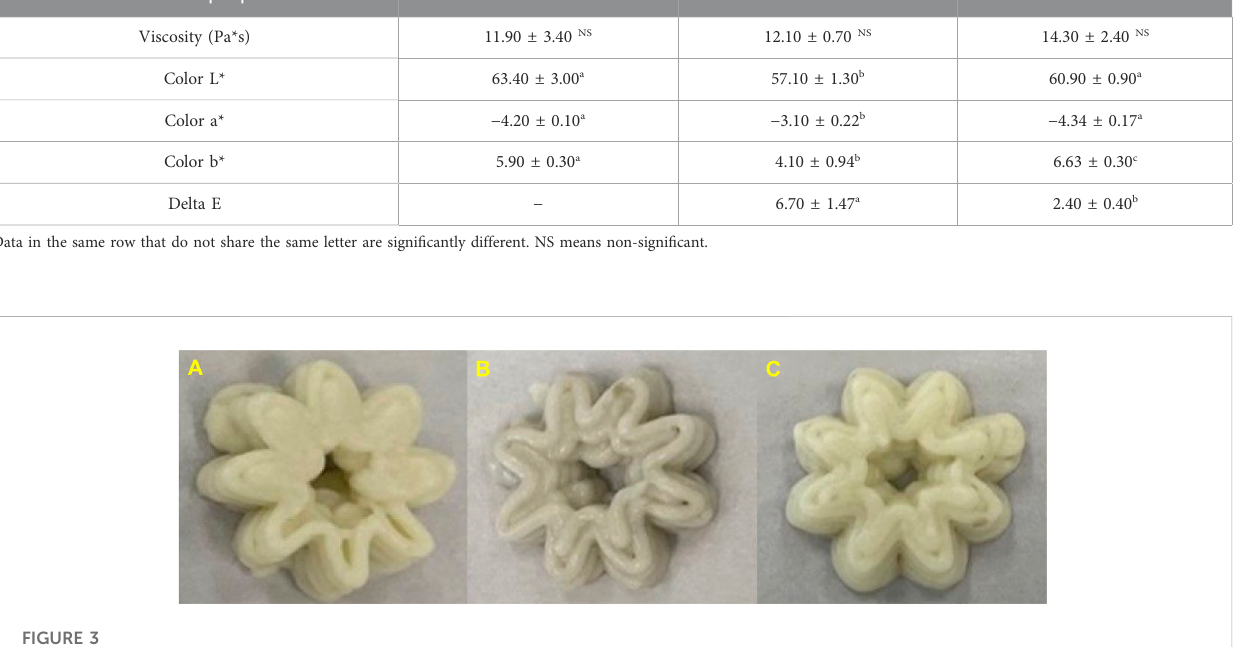
TABLE 5 Instrumental properties of mashed potatoes samples (control, SBPW, or TW). Instrumental